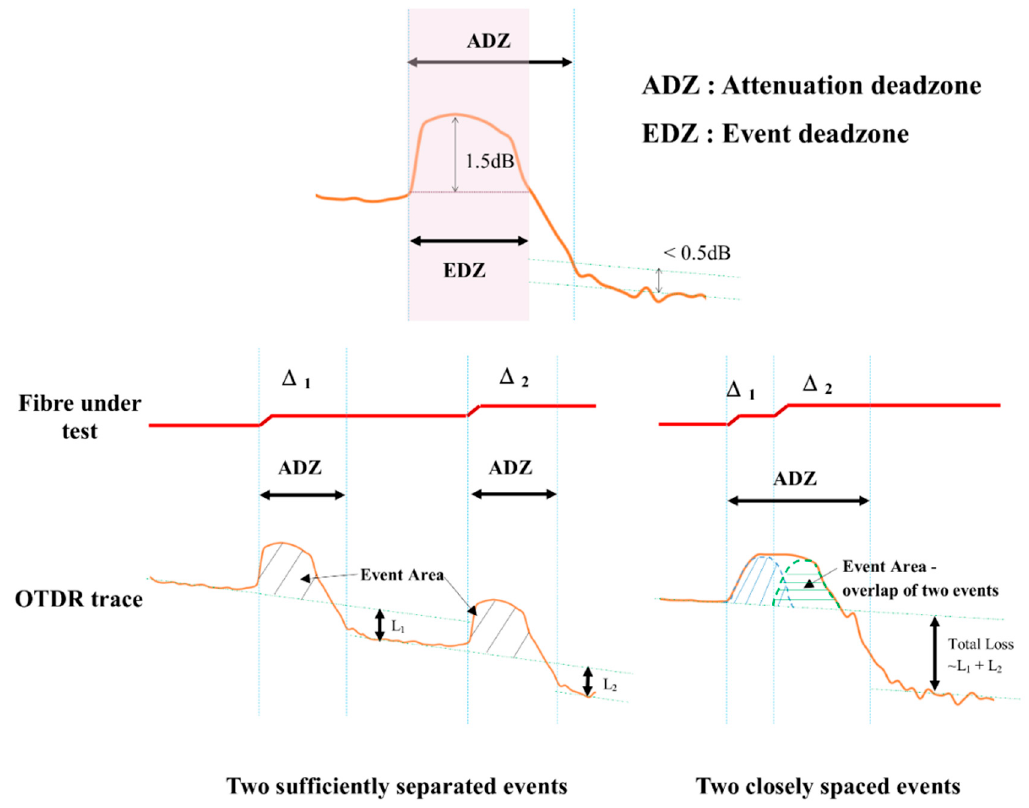
Figure 2. Dead zones and their effects on the measurement resolution.